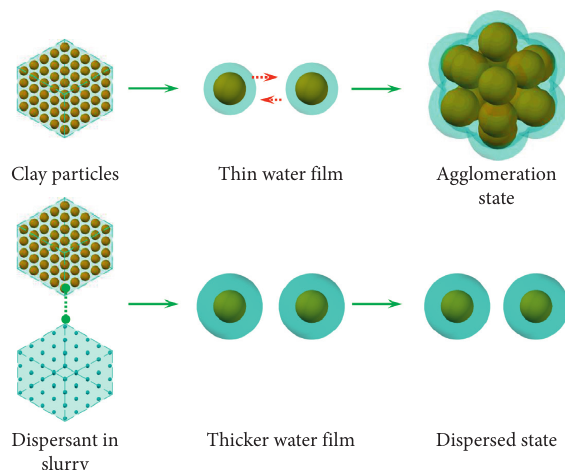
Figure 14: Mechanism of dispersant effects on clay particles.